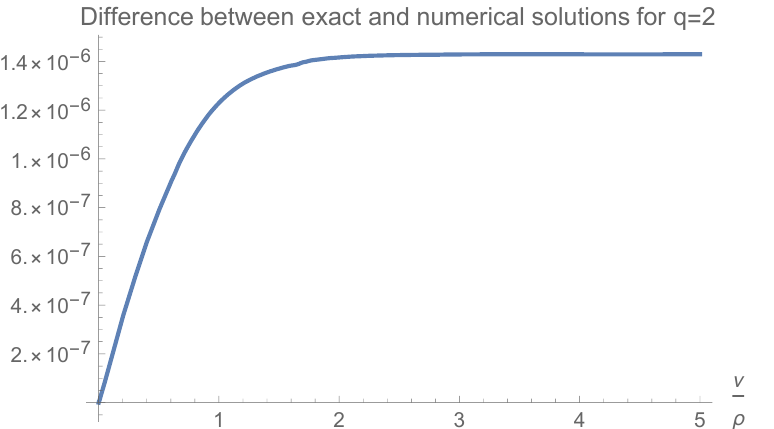
Figure 9 . Case q = 2 and l = 2: plot of the di(cid:11)erence between the exact solution (5.12a), and the normalized numerical solution for the scalar (cid:12)eld (cid:30) with initial data speci(cid:12)ed at (cid:23) determined by the truncated power series solution.